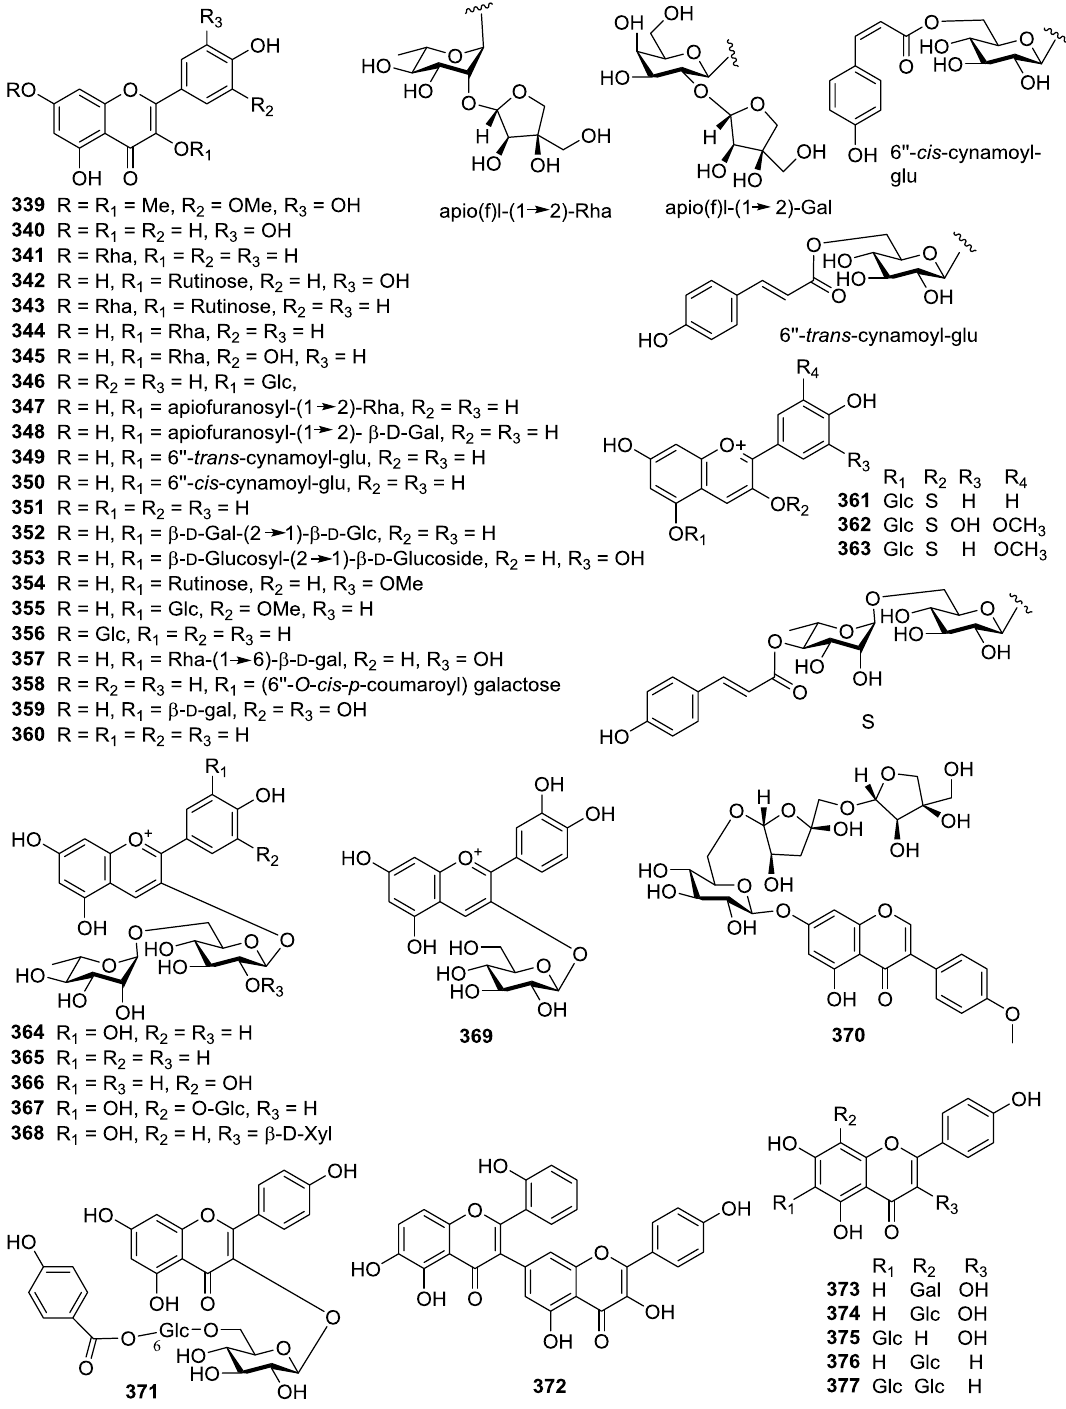
antimalarial activity against P. falciparum chloroquine- antiplasmodial activity on hepatic trophozoites of P. vivax . resistant FCB-1 strain (IC = 27 and 16 μM) [247]. Com- All the steroids reduced the number of hepatic P. vivax 50 pounds 511 – 515 from aerial parts of S. nudum demonstrated trophozoites. Among them, 506 and 512 reduced the number